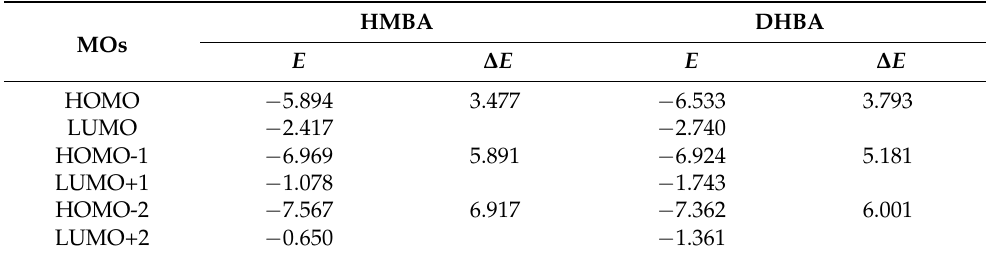
Table 3. The orbital energies and their energy gaps of examined compounds; HMBA and DHBA , units are in eV. HMBA DHBA MOs E ∆ E E ∆